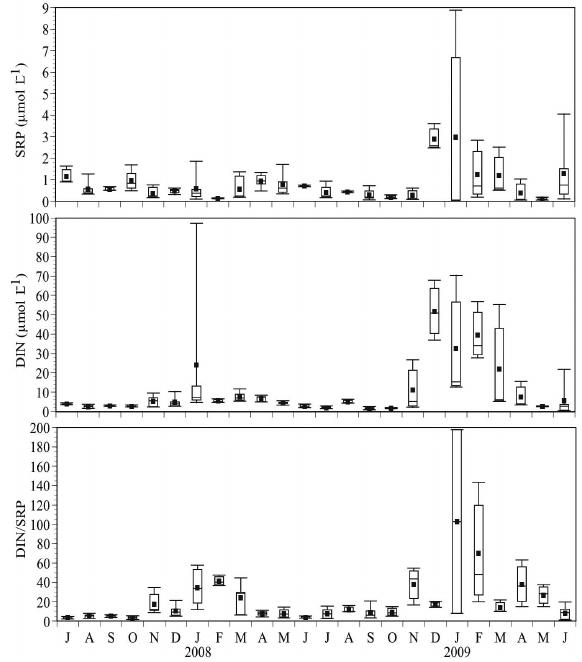
Fig . 4. – Seasonal variations in the main nutrients and the DIN/SRP ratio in Cabras Lagoon during the investigation period. The whisk- ers extend from the 10th percentile to the 90th